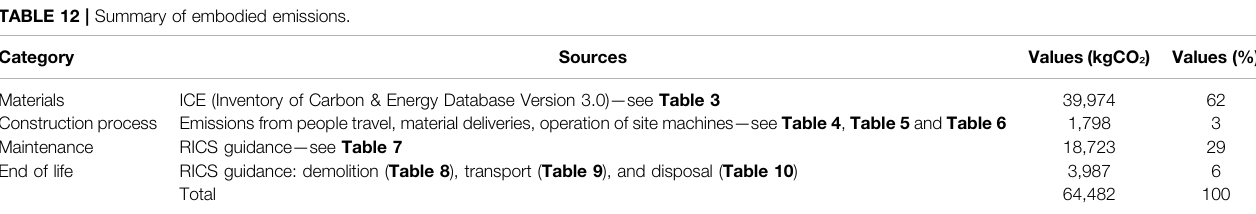
TABLE 12 | Summary of embodied emissions.